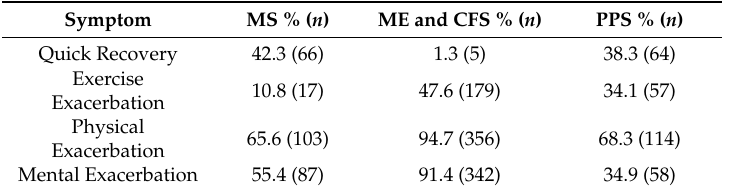
Table 2. Percentage of supplemental DePaul Symptom Questionnaire (DSQ) post-exertional malaise (PEM) questions reported positive by patient illness.